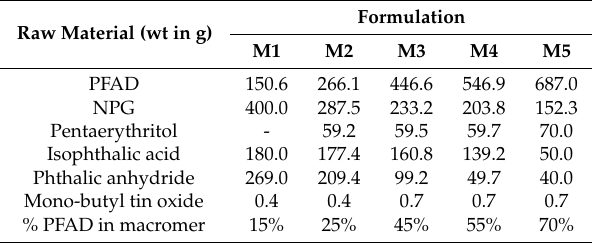
Table 1. Formulations of the Palm fatty acid distillate (PFAD) hydroxyl terminated